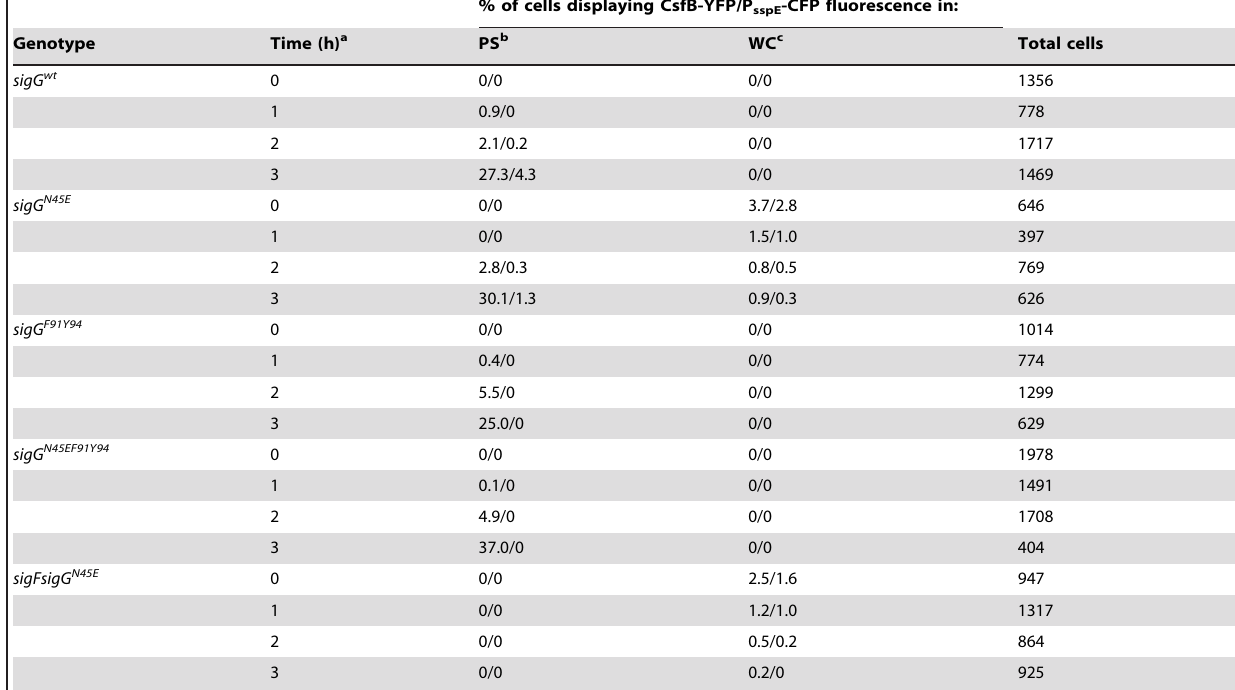
% of cells displaying CsfB-YFP/P sspE -CFP fluorescence